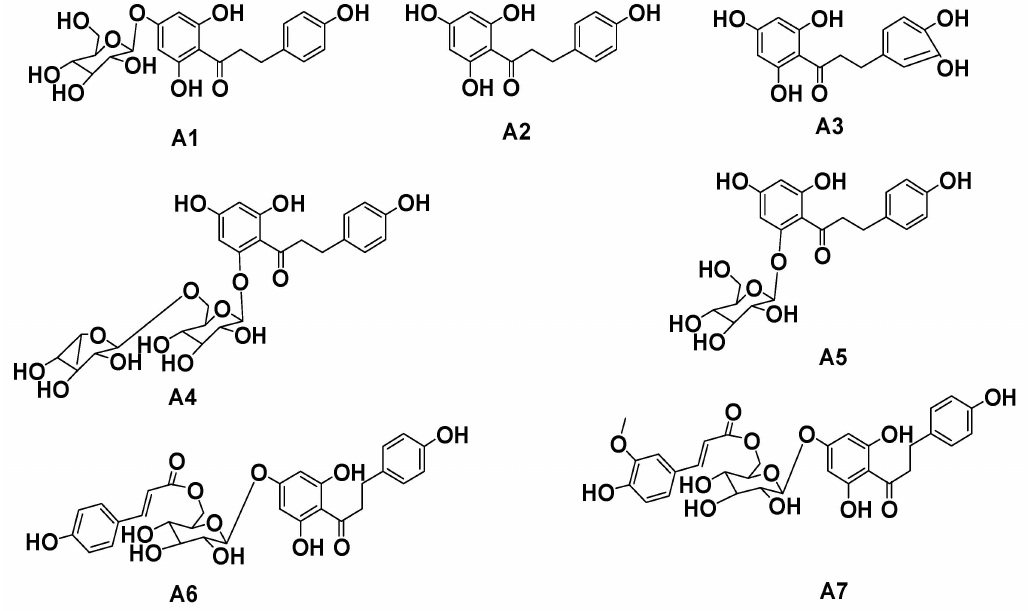
Figure 1. Structure of dihydrochalcone monomer compounds A1 – A7